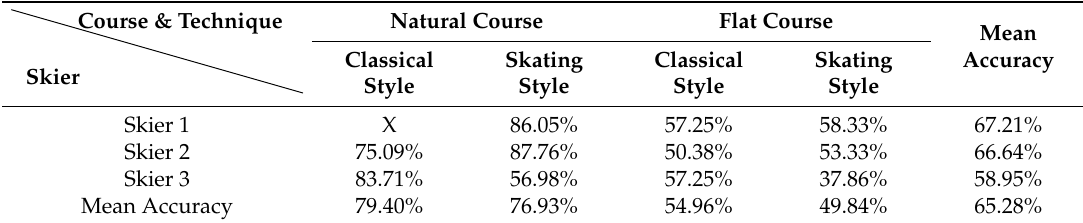
Table 16. Classification accuracies for the first three skiers using the k-nearest neighbors machine learning model when a leave-one-out type of testing is performed using the sports biomechanics configuration of